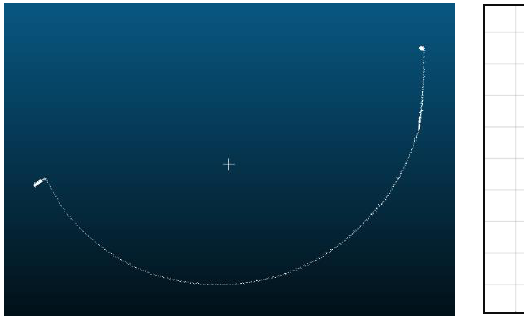
Figure 6. 2D bucket trajectory.